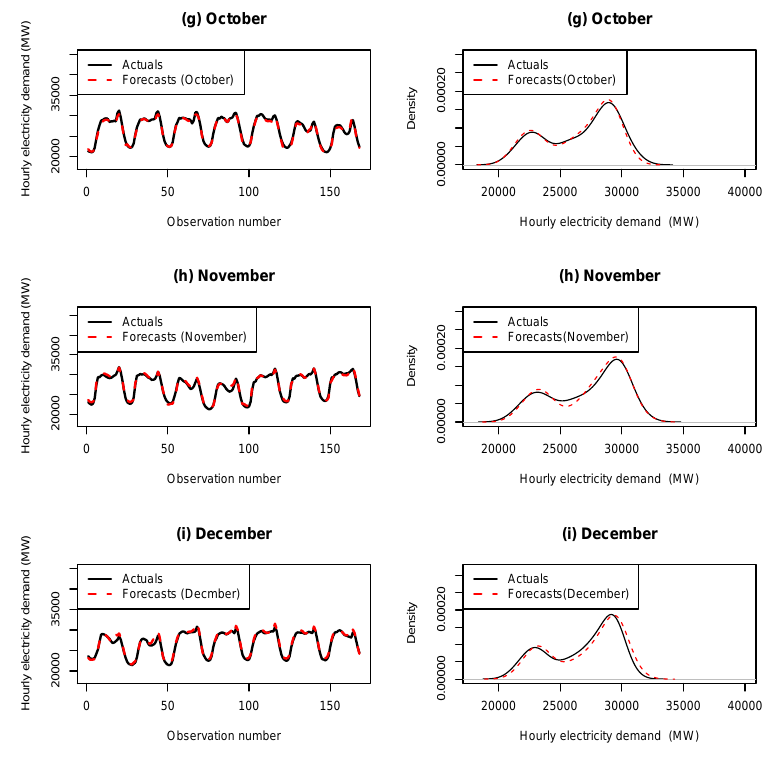
Figure A3. Hourly load superimposed with forecasts for the first 168 forecasts of each month of the months October to December 2012 together with their respective